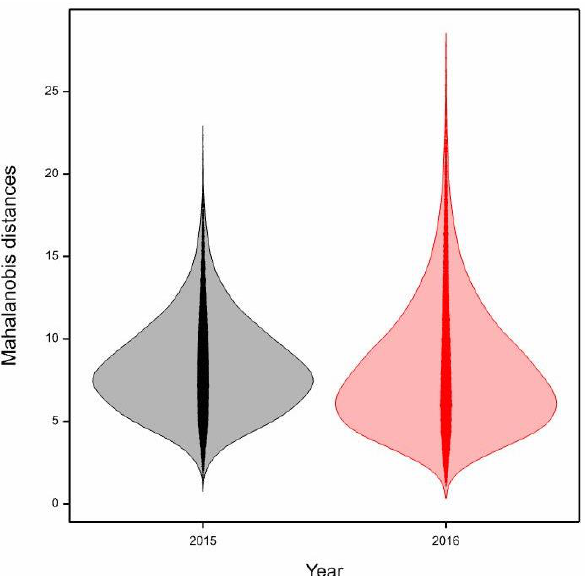
Figure 3. Range of Mahalanobis distances between all studied genotypes in two years of study.